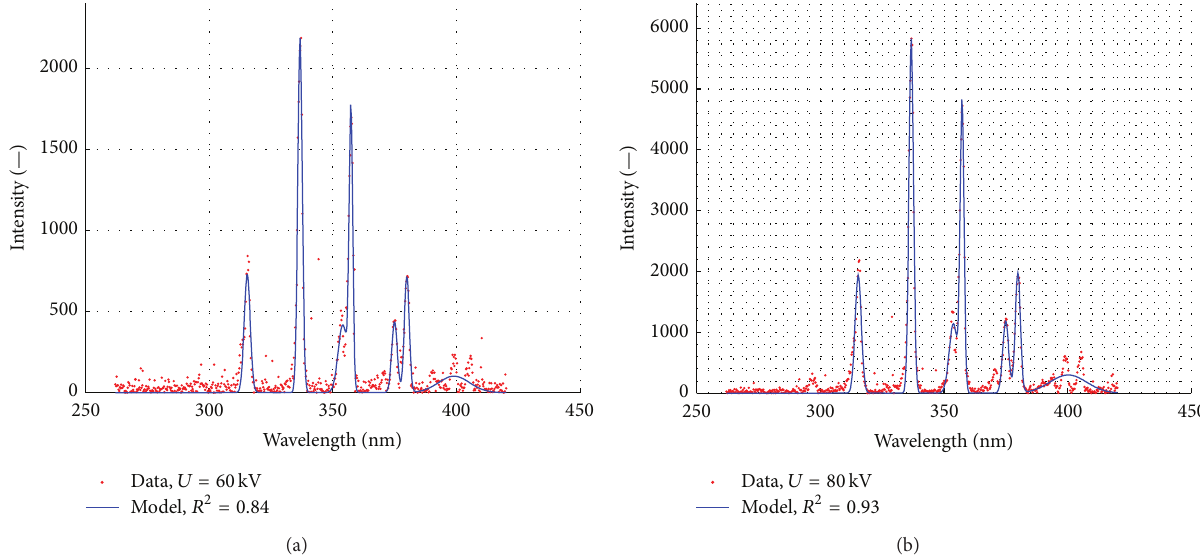
Figure 14: Intensity spectra of recorded and modeled light emission for selected values of PD generation voltages: (a) 0.56 𝑈 𝑝 = 60 kV and (b) 0.89 𝑈 𝑝 = 80